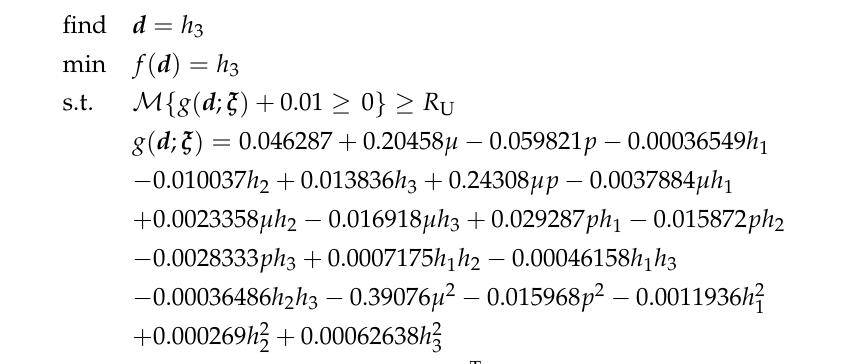
Figure 7. The comparative objective value of disc brakes under different reliability levels.